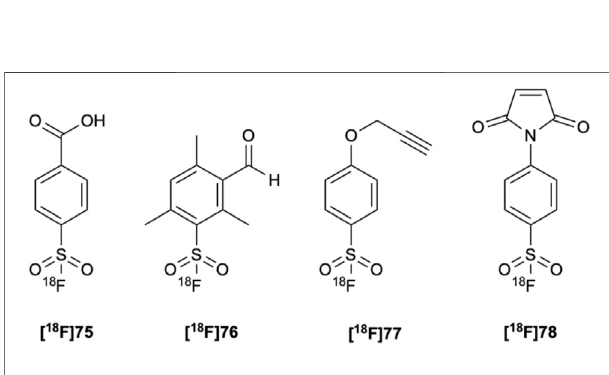
FIGURE11|[ 18 F]75 – 78 canbesynthesizedinhighradiochemicalyields from their corresponding sulfonyl chlorides with [ 18 F]CsF in 50% aqueous solutions at room temperature in only 15 min.